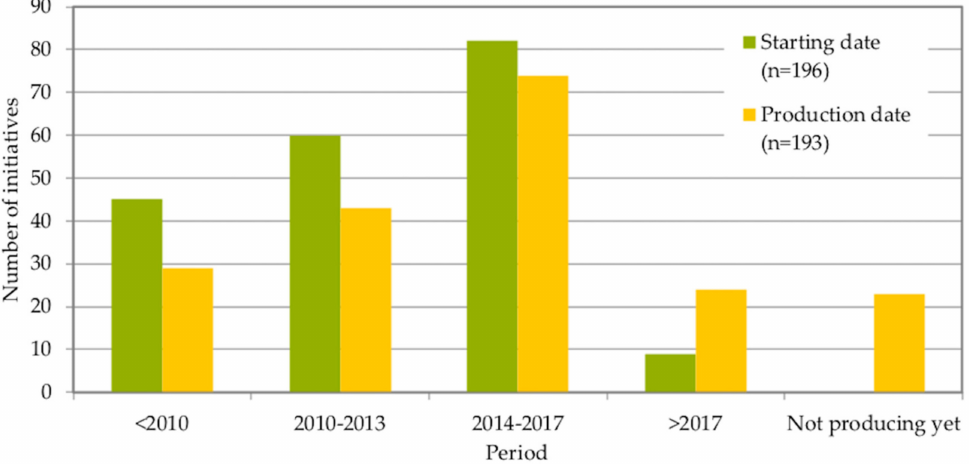
Figure 2. Starting dates of the initiatives and of